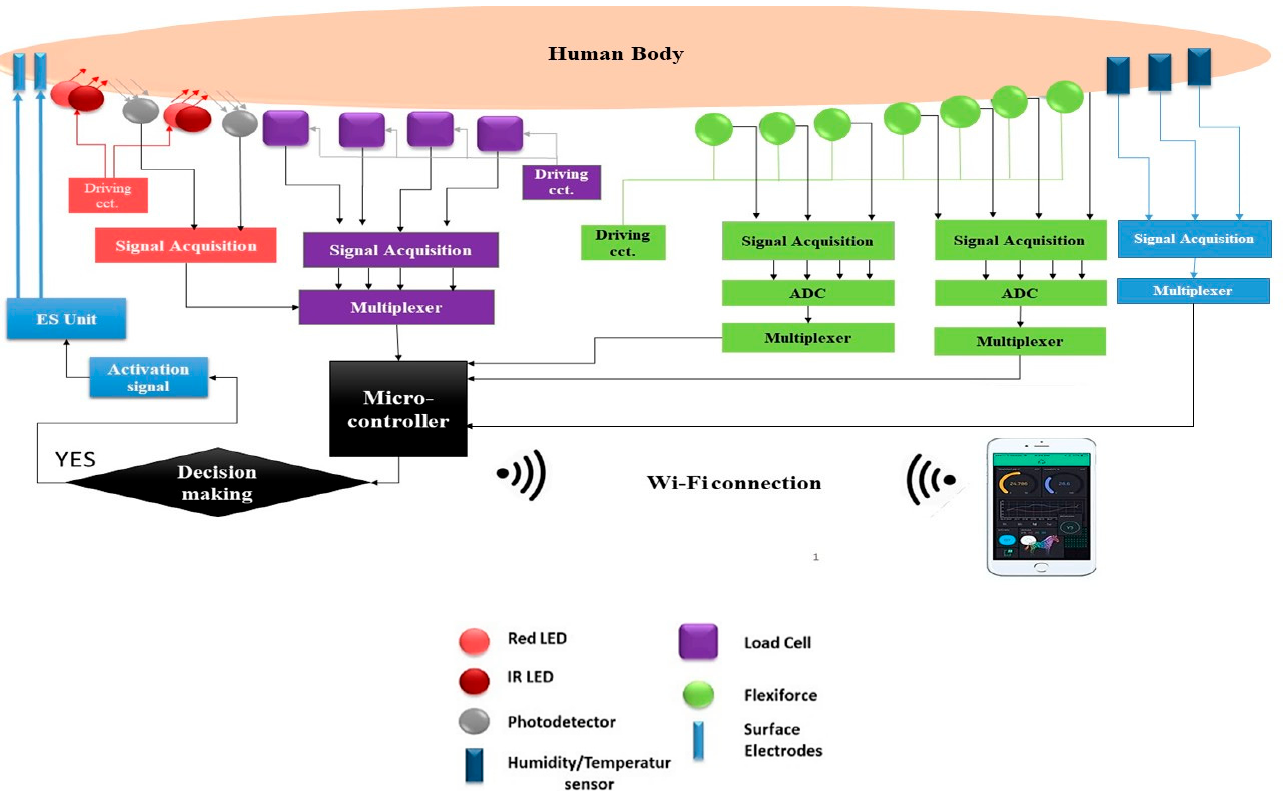
Figure 1. Proposed system block diagram showing the sensors’ attachment to the human body and Wi-Fi communication with the user interface and ES unit.